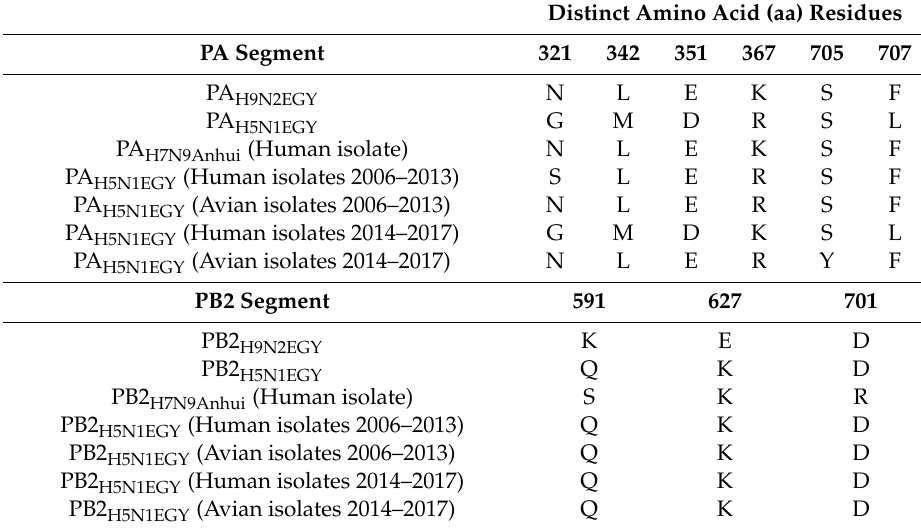
Table 3. Predominance of the distinct aa residues [28,37,38] in the studied polymerase acidic (PA) and polymerase basic 2 (PB2) proteins in Egyptian avian versus Egyptian human H5N1